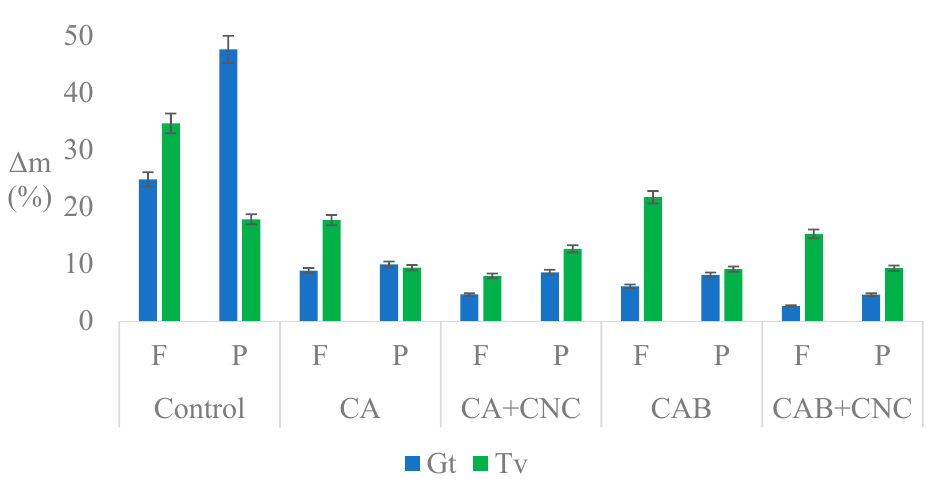
Figure 2. Mass loss ( ∆ m) after the decay test of brown wood rot (Gt) and white wood rot (Tv). Control: Control sample (uncoated wood in oven at 60 ◦ C for 3 days before fungi inoculation). F: F. sylvatica . P: P. abies . CA: Commercial acrylic waterborne coating. CA+CNC: CA with addition of 2% CNC gel. CAB: Commercial acrylic waterborne coating with biocides. CAB+CNC: CAB with addi- tion of 2% CNC gel.